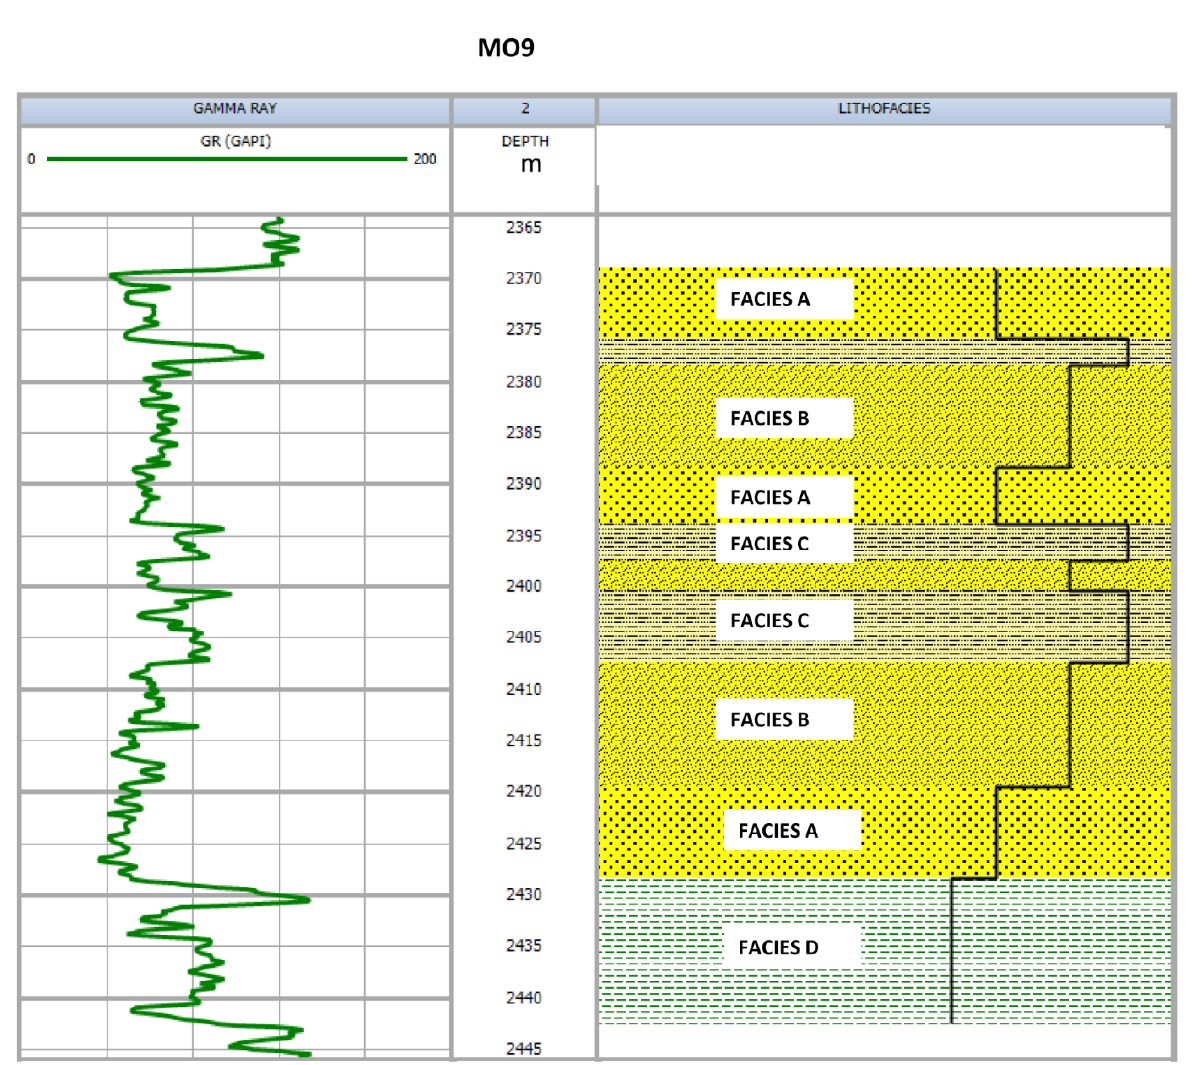
Figure 2. Well MO9 showing gamma ray log in track one and four different facies classified as facies A, B, C and D in track